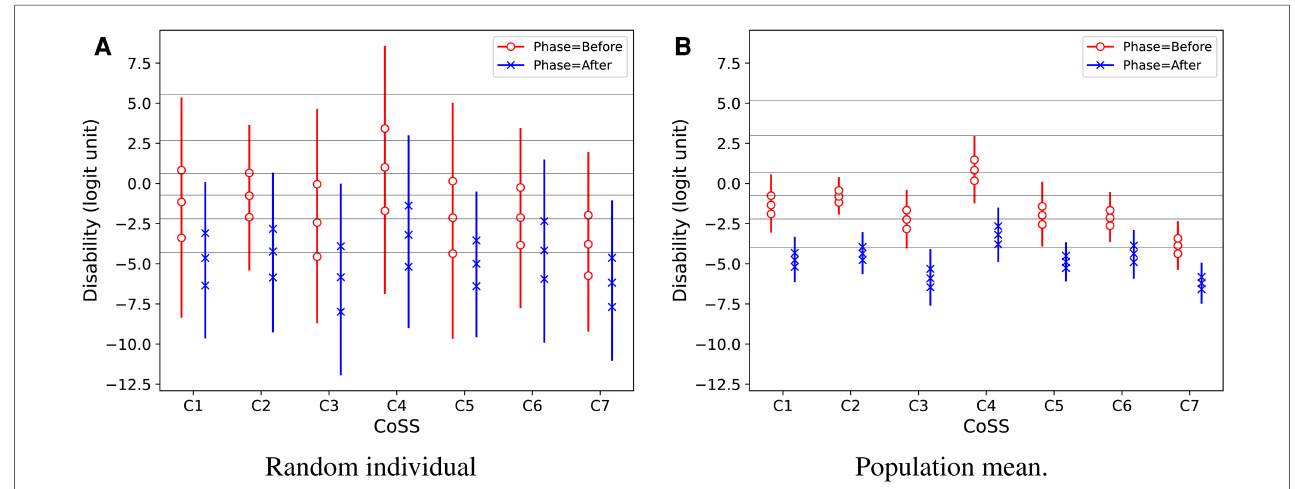
FIGURE 5 Predictive Disability results for a random individual in the population ( A ) and for the population mean ( B ), as estimated by regression for the combined effects of test phase and CoSS categories. Vertical lines show 95% credible intervals for the marginal distributions for each category. Marker symbols show 25-, 50-, and 75-percentiles. Thin horizontal lines across the plots show median estimated response thresholds for the seven ordinal rating categories.